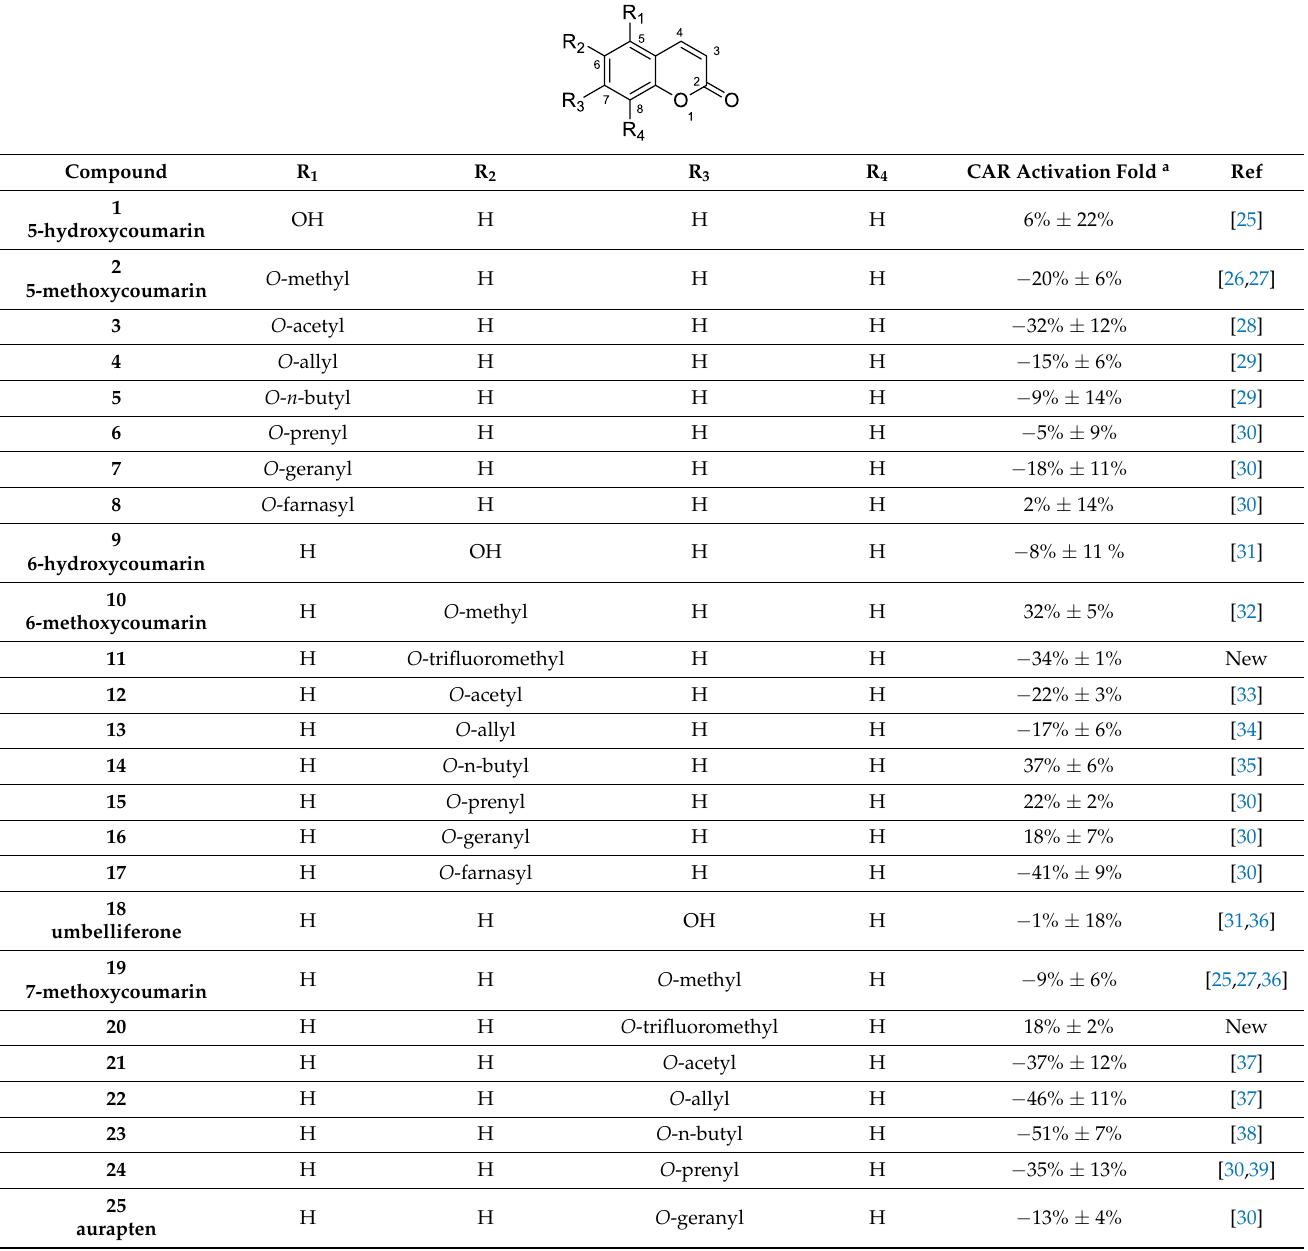
Table 1. Mono-substituted coumarin structures and their CAR activation.